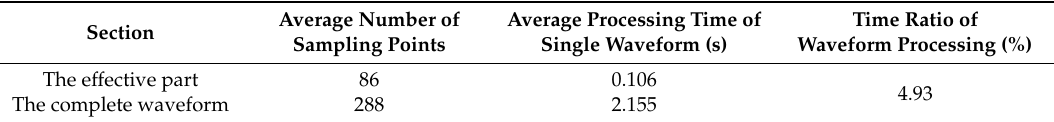
Table 2. Efficiency comparison of single-waveform